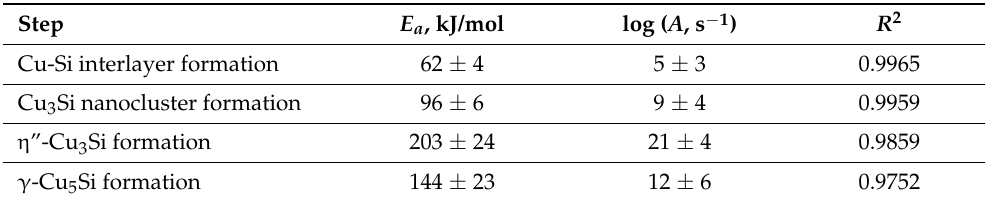
Figure 5. Kissinger plots for the phase formation during the solid-state reaction in the Cu/a-Si bilayer films based on the electron diffraction data. Table 3. Kinetic parameters for the phase formation during solid-state reaction in the Cu/a-Si bilayer films based on electron diffraction data.